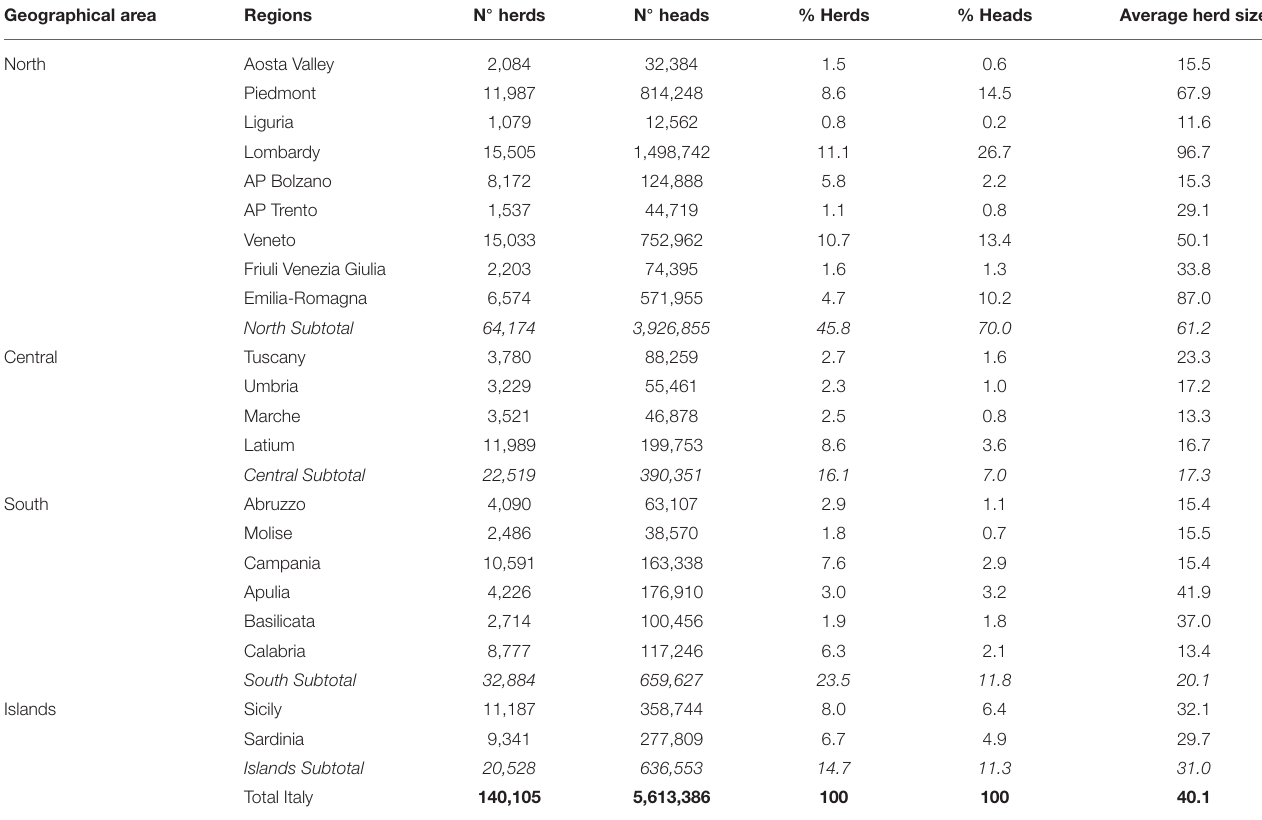
TABLE 1 | Cattle distribution in Italy at 30th June 2020. Geographical area Regions N ◦ herds N ◦ heads % Herds % Heads Average herd size